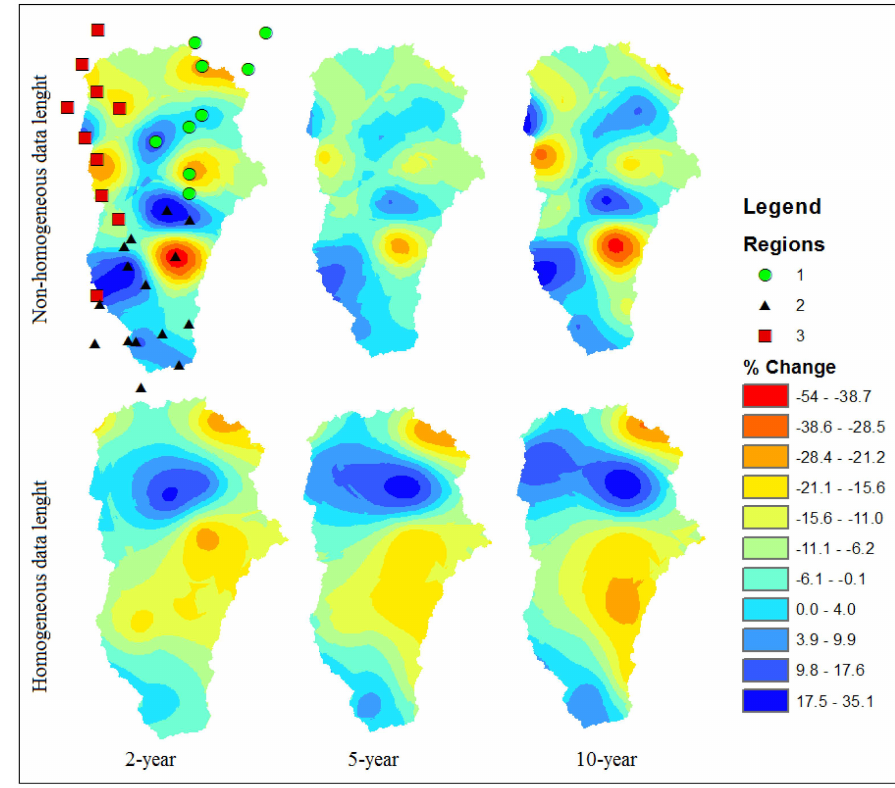
Figure 7. Comparison of the percentage changes in heavy rainfall for homogeneous (1950–2010) as well as for non-homogeneous (variable data length) periods considering two-, five- and 10-year return periods (R.P.). All maps have the same